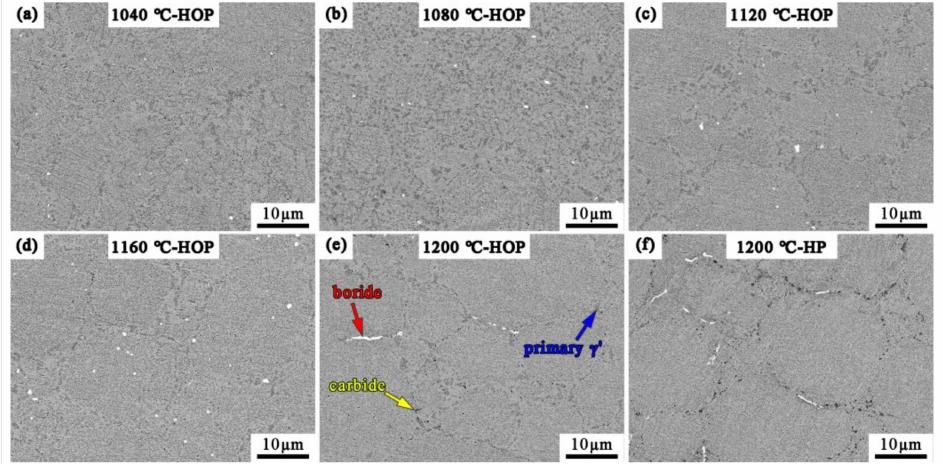
Figure 6. BSE images of the HOPed and HPed samples: ( a ) 1040 ◦ C-HOP; ( b ) 1080 ◦ C-HOP;